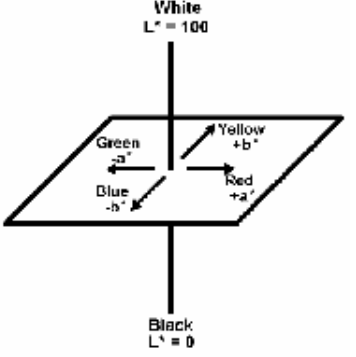
Figure 1. Definition of CIE